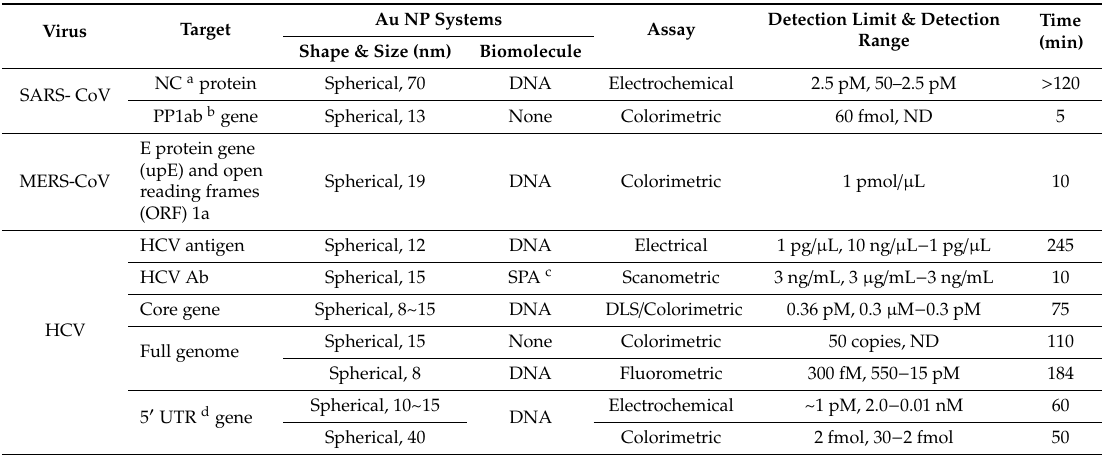
Table 3. Some important Au NP-based strategies towards the detection of viruses